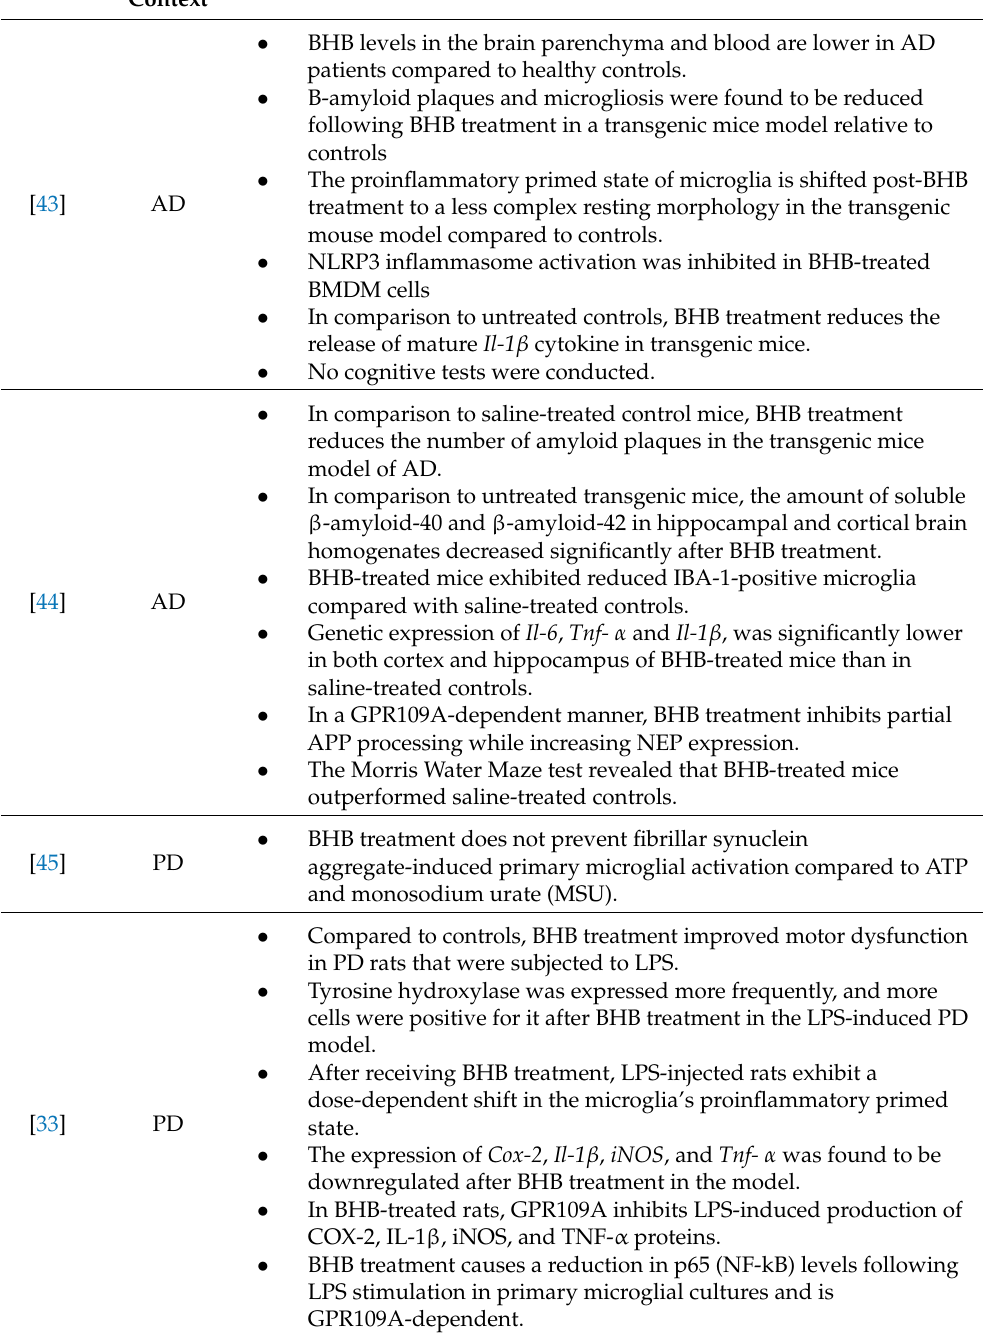
Table 1. Summary of data extracted from eligible